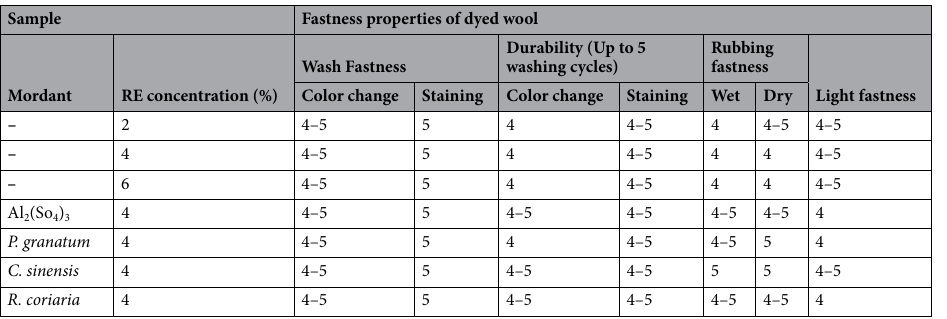
Table 3. Fastness properties of wool samples dyed with RE (Wash, light and rubbing fastness on gray scale: 1, poor; 2, fair; 3, moderate; 4, good; 5, excellent).